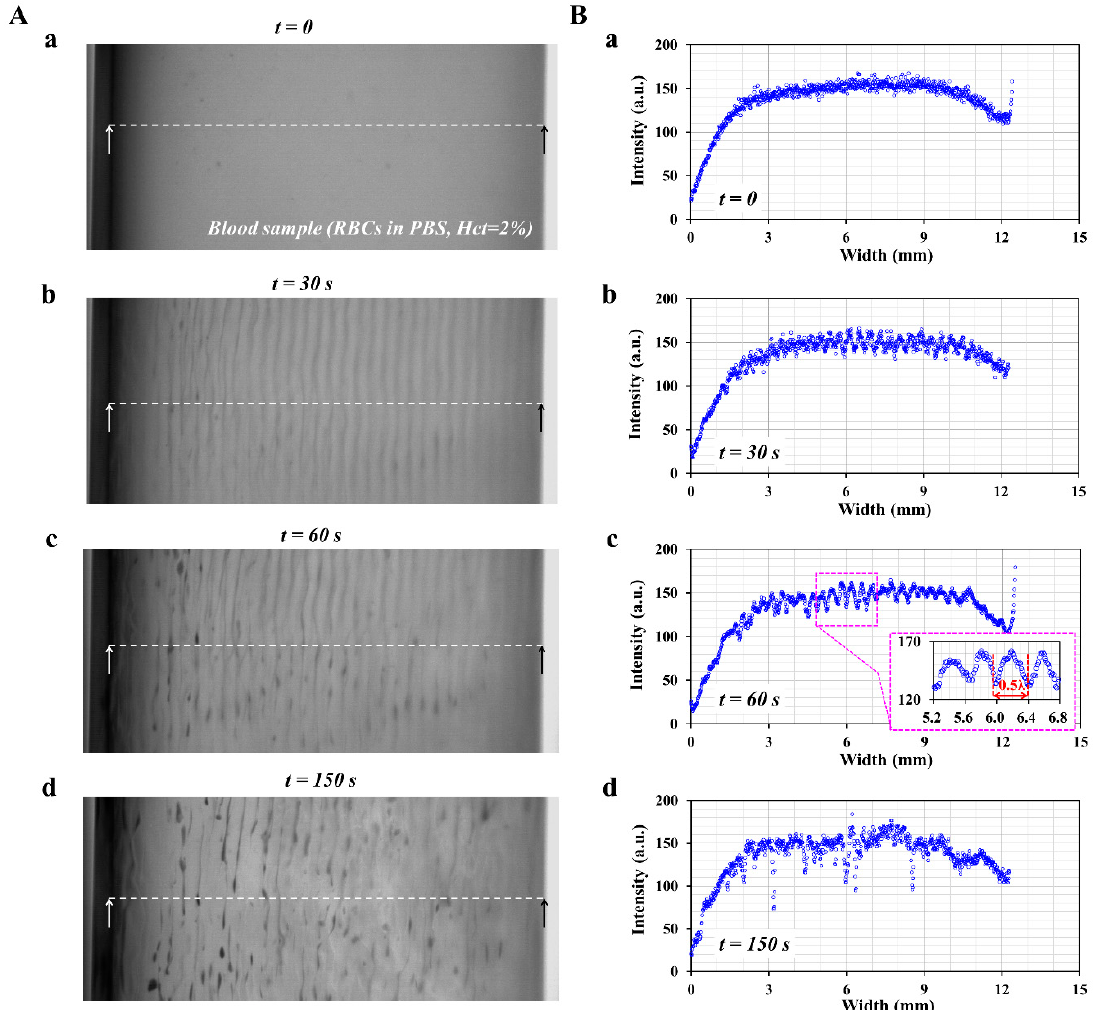
Figure 3. Experimental visualization of focusing and sedimentation of RBCs in ultrasonic transducer. ( A ) Snapshot captured at a specific time ( t ) (( a ) t = 0, ( b ) t = 30 s, ( c ) t = 60 s, and ( d ) t = 150 s). ( B ) Variations of image intensity obtained along a straight line with respect to time ( t ) (( a ) t = 0, ( b ) t = 30 s, ( c ) t = 60 s, and ( d ) t = 150 s). Inset of Figure 3B(c) shows periodic patterns of image intensity along the width direction.